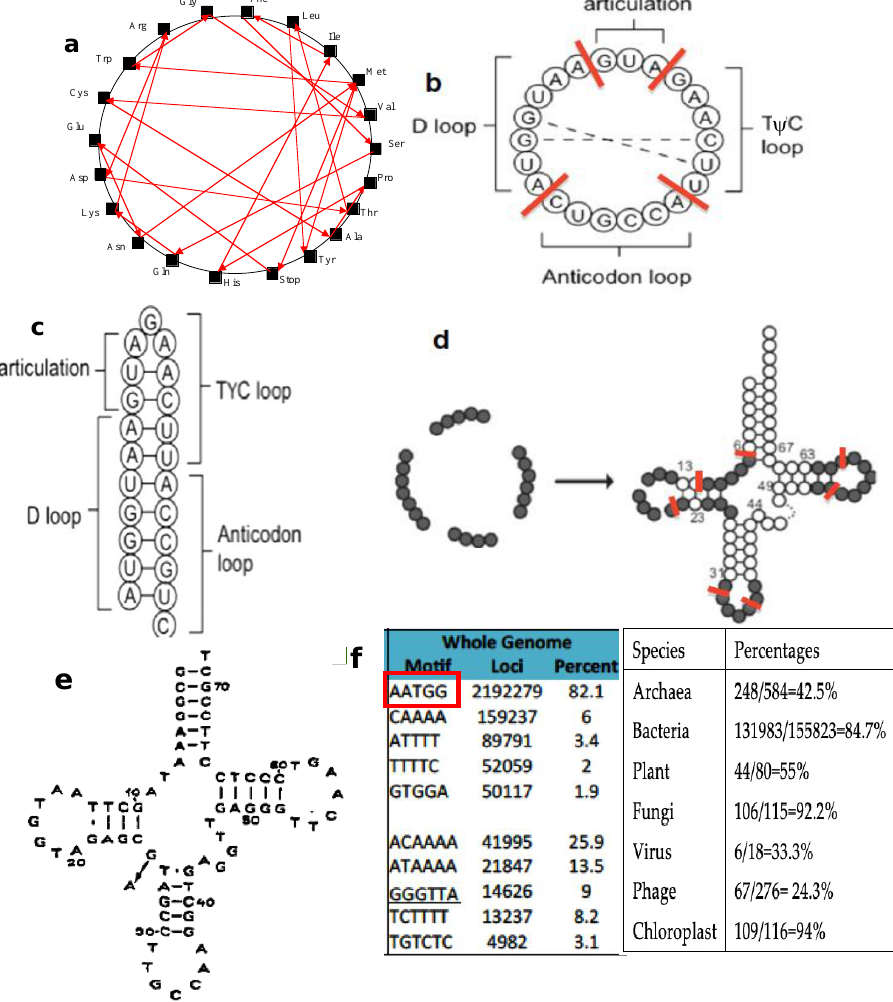
Figure 1. Computation of the Archetypal Loop AL. ( a ) Hamiltonian path in the graph having amino acids as vertices; ( b ) AL ring AUGGUACUGCCAUUCAAGAUG; ( c ) Optimal hairpin form of AL; ( d ) Urancestral tRNA-Gly [6], where nucleotides common with AL are indicated in black. ( e ) GlytRNA GCC of Œnothera coquimbensis [53], whose loops (D-, anti-codon, articulation and T Ψ -loops) fit quasi-perfectly AL; ( f ) pentamer frequencies in whole human genome [42] and percentages of tRNAs containing TGGTA and TTCNA in their D- and T Ψ -loops, among tRNAs having NTGCCAN as an anticodon loop in di ff erent species of the tRNADB-CE database